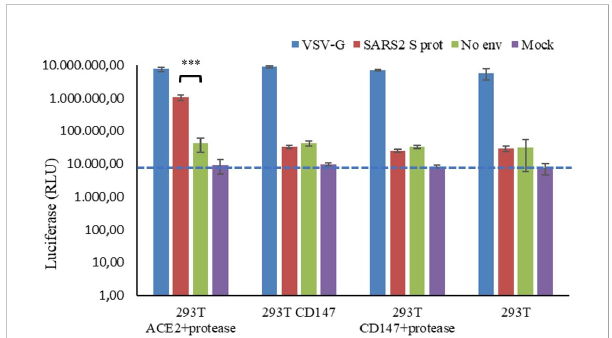
FIGURE 1 Luciferase activity of SARS-CoV-2 pseudovirus infection in HEK 293T cells expressing the ACE2 o the CD147 receptors. HEK 293T cells were transiently transfected with ACE2 and the protease TMPRSS2, or with CD147 alone or in combination with the TMPRSS2 protease. At 24 h post-transfection, cells were infected with SARS- CoV-2 (SARS2 S prot), VSV-G or naked (No Env) pseudovirions. Mock indicate fresh culture medium. After 48 h, cells were lysed and luciferase activity was measured. The average of three independent experiments conducted with quadruplicate samples are shown. Student ’ s t-test was performed, ***p<0.001. The blue line indicates background signal of mock infection (no virus). RLU: relative luminescence units in log